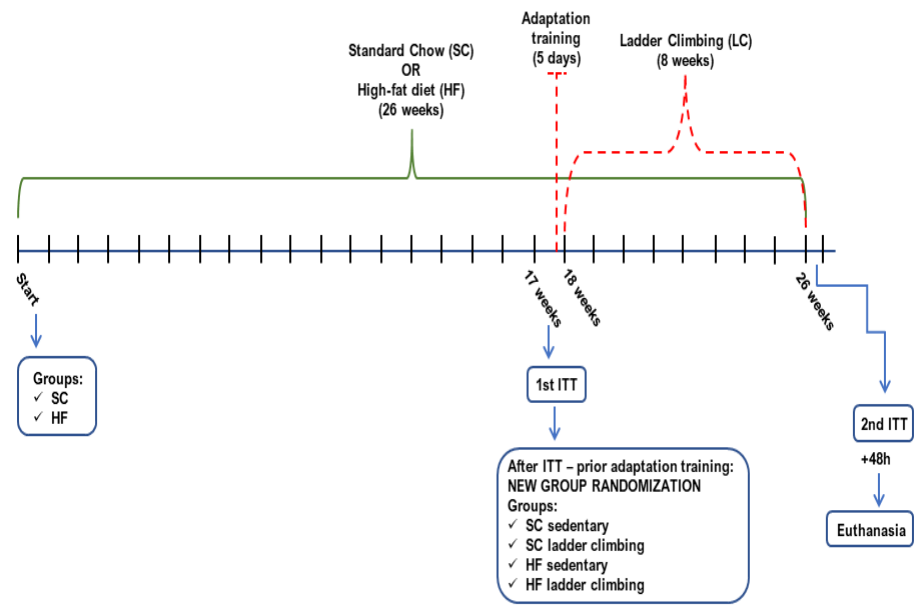
Figure 1. Timeline depicting the experimental design (SC- standard chow; HF- high-fat; ITT- insulin tolerance test).